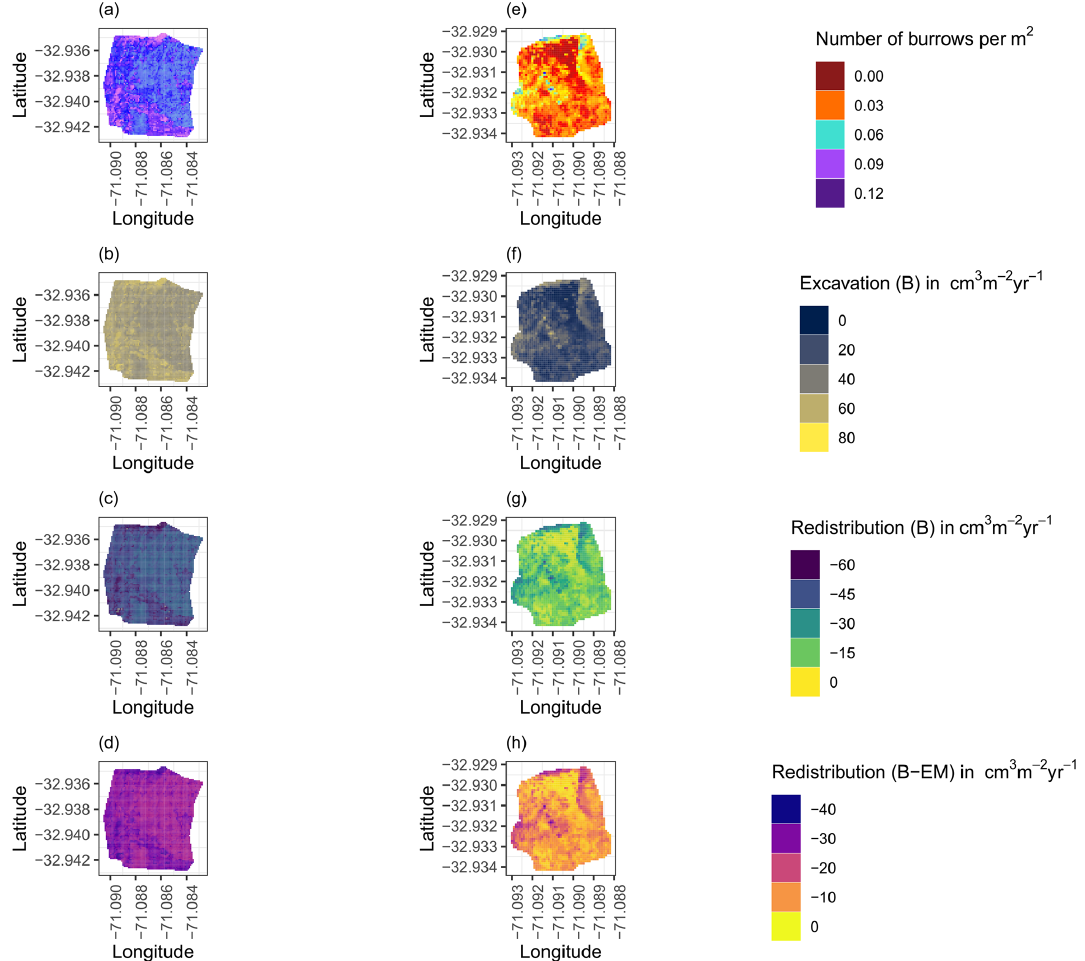
Figure A8. Hillslope-wide volume of redistributed sediment for a time period of 1 year at LC for the (a–d) north-facing hillslope and (e–h) south-facing hillslope. (a, e) Density of burrows as estimated by Grigusova et al. (2021). (b, f) Volume of the sediment excavated by the animals. (c, g) Volume of the sediment redistributed during rainfall events within burrows. (d, h) Volume of additionally redistributed sediment during rainfall events due to the presence of the burrows. The values were calculated per burrow as stated in Sect. 3.7 by subtracting the sediment volume redistributed within burrows from the sediment volume redistributed within burrow-embedded area and then upscaled. B stands for burrow, and EM stands for burrow-embedded